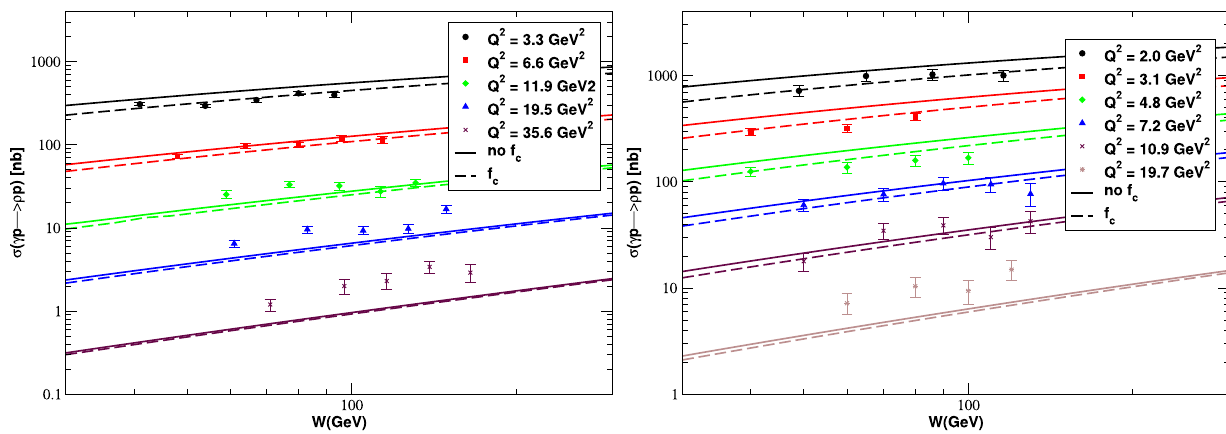
Fig. 4 Energy dependence of the exclusive ρ production cross section for different values of the photon virtuality Q 2 . Data from Refs. [60,61]